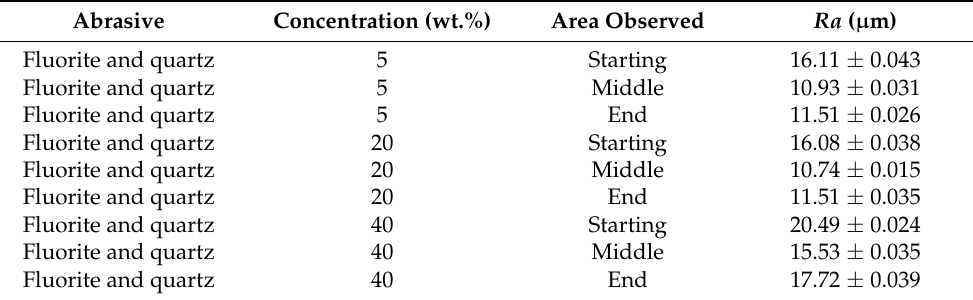
Table 10. The roughness of AISI 4145H steel after being abraded by slurry with the mixed abrasives of fluorite and quartz. Abrasive Concentration (wt.%) Area Observed Ra ( µ m) Fluorite and quartz 5 Starting 16.11 ± 0.043 Fluorite and quartz 5 Middle 10.93 ± 0.031 Fluorite and quartz 5 End 11.51 ± 0.026 Fluorite and quartz 20 Starting 16.08 ± 0.038 Fluorite and quartz 20 Middle 10.74 ± 0.015 Fluorite and quartz 20 End 11.51 ± 0.035 Fluorite and quartz 40 Starting 20.49 ± 0.024 Fluorite and quartz 40 Middle 15.53 ± 0.035 Fluorite and quartz 40 End 17.72 ±